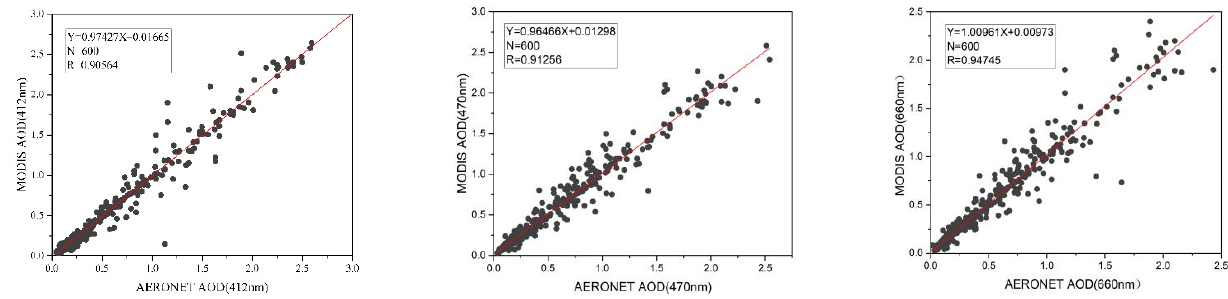
Figure 4. Verification of AOD for MODIS and AERONET at 412 nm, 470 nm and 660 nm.